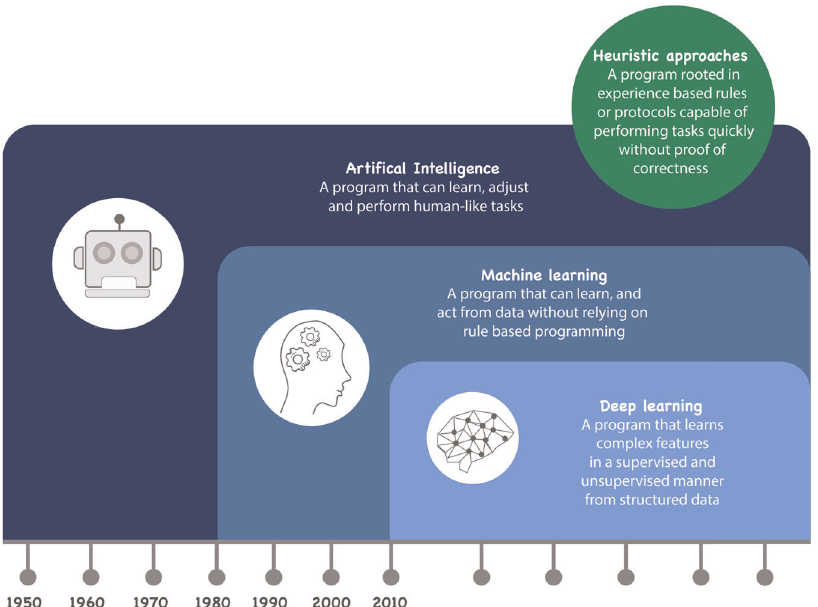
Fig. 6 Sleep classi fi cation algorithms can be based on heuristic approaches or Arti fi cial Intelligence. We describe machine learning/ statistical learning approaches and deep-learning approaches within